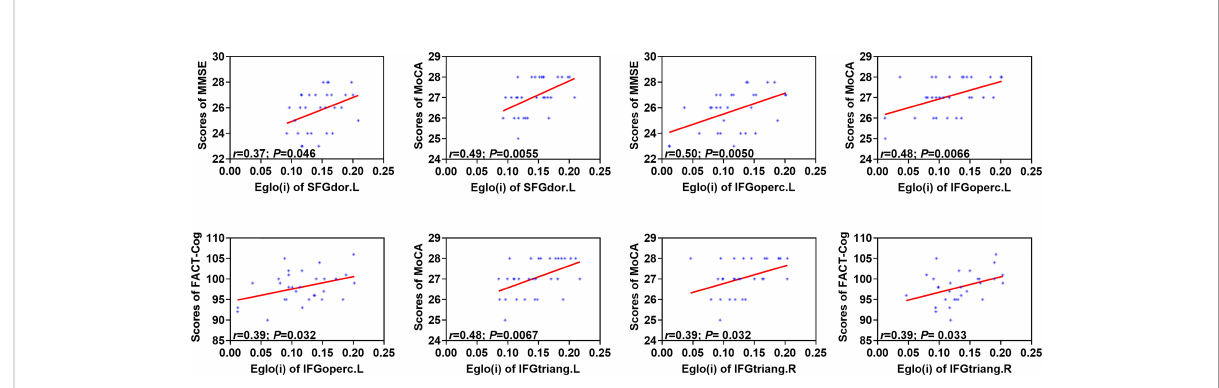
FIGURE 4 Associations between altered nodal global ef fi ciency and cognitive assessment scores in the patient group. MMSE, Mini Mental State Exam; MoCA, Montreal Cognitive Assessment; FACT-Cog, Functional Assessment of Cancer Therapy-Cognitive Function. E glo(i) , nodal global ef fi ciency. SFGdor.L, left superior frontal gyrus (dorsolateral); IFGoperc.L, left inferior frontal gyrus (opercular part); IFGtriang. L, left inferior frontal gyrus (triangular part); IFGtriang.R, right inferior frontal gyrus (triangular part). The associations were explored by the method of Pearson ’ s correlation and P < 0.05 was considered statistically signi fi